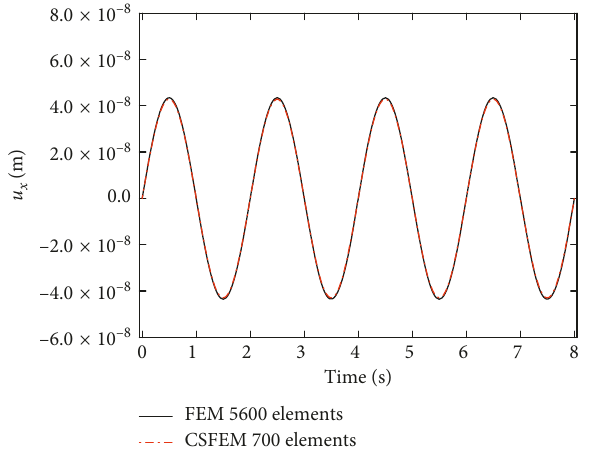
Figure 28: The variation of the displacement u energy harvester at point B with respect to time.